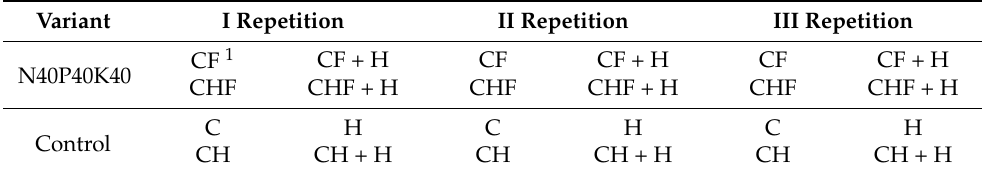
Table 1. Experimental layout.